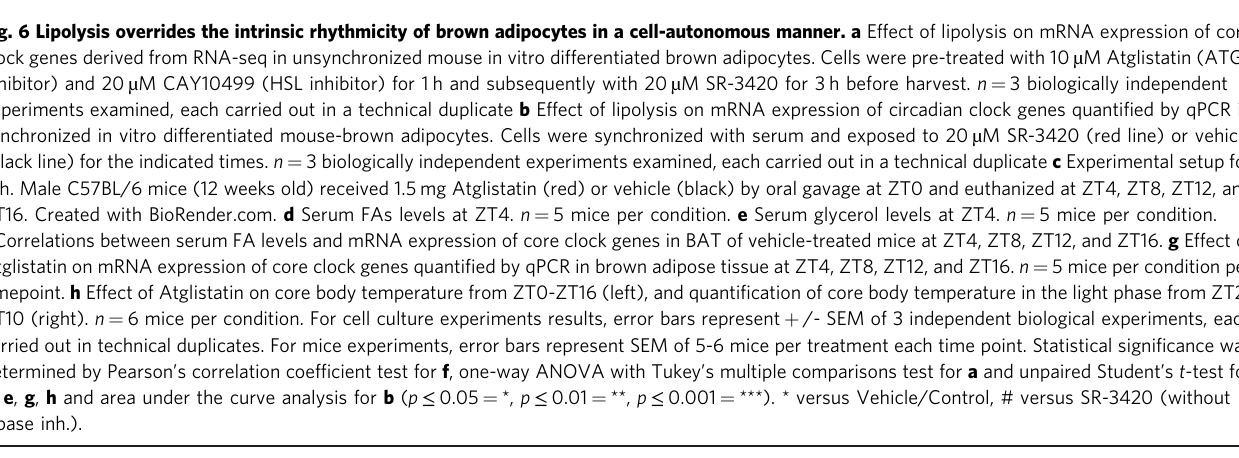
Fig. 6 Lipolysis overrides the intrinsic rhythmicity of brown adipocytes in a cell-autonomous manner. a Effect of lipolysis on mRNA expression of core clock genes derived from RNA-seq in unsynchronized mouse in vitro differentiated brown adipocytes. Cells were pre-treated with 10 µ M Atglistatin (ATGL inhibitor) and 20 µ M CAY10499 (HSL inhibitor) for 1 h and subsequently with 20 µ M SR-3420 for 3 h before harvest. n = 3 biologically independent experiments examined, each carried out in a technical duplicate b Effect of lipolysis on mRNA expression of circadian clock genes quanti fi ed by qPCR in synchronized in vitro differentiated mouse-brown adipocytes. Cells were synchronized with serum and exposed to 20 µ M SR-3420 (red line) or vehicle (black line) for the indicated times. n = 3 biologically independent experiments examined, each carried out in a technical duplicate c Experimental setup for d-h. Male C57BL/6 mice (12 weeks old) received 1.5 mg Atglistatin (red) or vehicle (black) by oral gavage at ZT0 and euthanized at ZT4, ZT8, ZT12, and ZT16. Created with BioRender.com. d Serum FAs levels at ZT4. n = 5 mice per condition. e Serum glycerol levels at ZT4. n = 5 mice per condition. f Correlations between serum FA levels and mRNA expression of core clock genes in BAT of vehicle-treated mice at ZT4, ZT8, ZT12, and ZT16. g Effect of Atglistatin on mRNA expression of core clock genes quanti fi ed by qPCR in brown adipose tissue at ZT4, ZT8, ZT12, and ZT16. n = 5 mice per condition per timepoint. h Effect of Atglistatin on core body temperature from ZT0-ZT16 (left), and quanti fi cation of core body temperature in the light phase from ZT2- ZT10 (right). n = 6 mice per condition. For cell culture experiments results, error bars represent + /- SEM of 3 independent biological experiments, each carried out in technical duplicates. For mice experiments, error bars represent SEM of 5-6 mice per treatment each time point. Statistical signi fi cance was determined by Pearson ’ s correlation coef fi cient test for f , one-way ANOVA with Tukey ’ s multiple comparisons test for a and unpaired Student ’ s t -test for d , e , g , h and area under the curve analysis for b ( p ≤ 0.05 = *, p ≤ 0.01 = **, p ≤ 0.001 = ***). * versus Vehicle/Control, # versus SR-3420